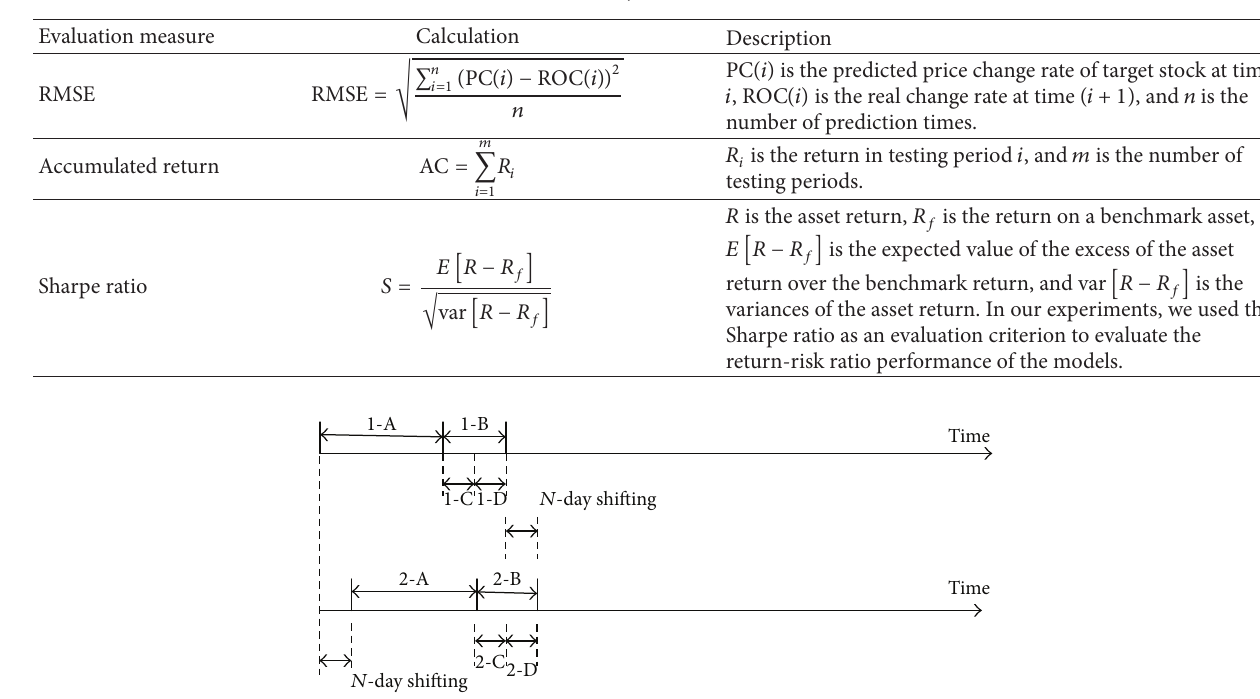
Table 11: Summary of evaluation measures.